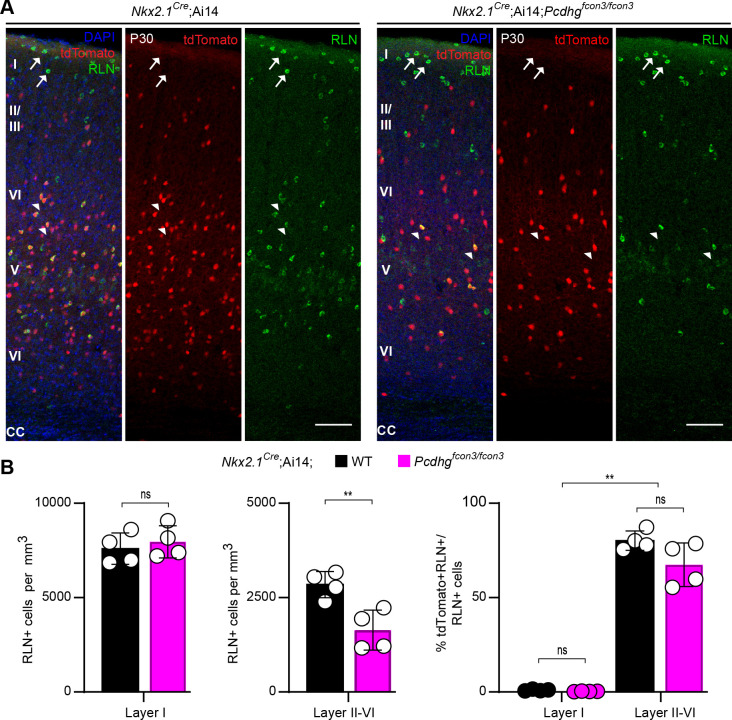
Numbers of Nkx2.1-derived RLN positive cINs are reduced in layers II-VI in Pcdhg-deficient mice.(A) Representative photographs of visual cortex (V1) in Nkx2.1Cre;Ai14;Pcdhg+/+ (Pcdhg WT, left panels) and Nkx2.1Cre;Ai14;Pcdhgfcon3/fcon3 (Pcdhg mutant, right panels) mice. Sections were stained for RLN, tdTomato, and DAPI. Arrows point to RLN+/tdTomato- cells and arrowhead points to RLN+/tdTomato+ positive cells. Scale bars 100 μm. (B) Quantifications of RLN+ cells in layer I and layers II-VI represented as density (left and middle graphs) and as percentage of Nkx2.1-derived cells by cortical layer (right graph) in the primary visual cortex (Mann-Whitney, p=0.4857 (Layer I, left graph), **p=0.0286 (Layers II-VI, middle graph); Kruskal-Wallis test P value<0.0001, adjusted p values **p=0.005 (right graph); n = 4 mice of each genotype).
Figure 3—figure supplement 2—source data 1.Quantification of Reelin positive cINs by cortical layer in the visual cortex of controls and Pcdhg loss of function mice.